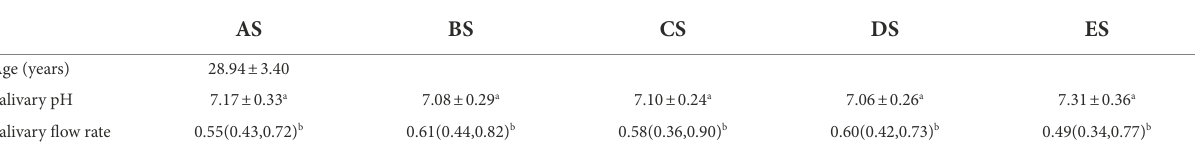
TABLE 1 Demographic data of the five